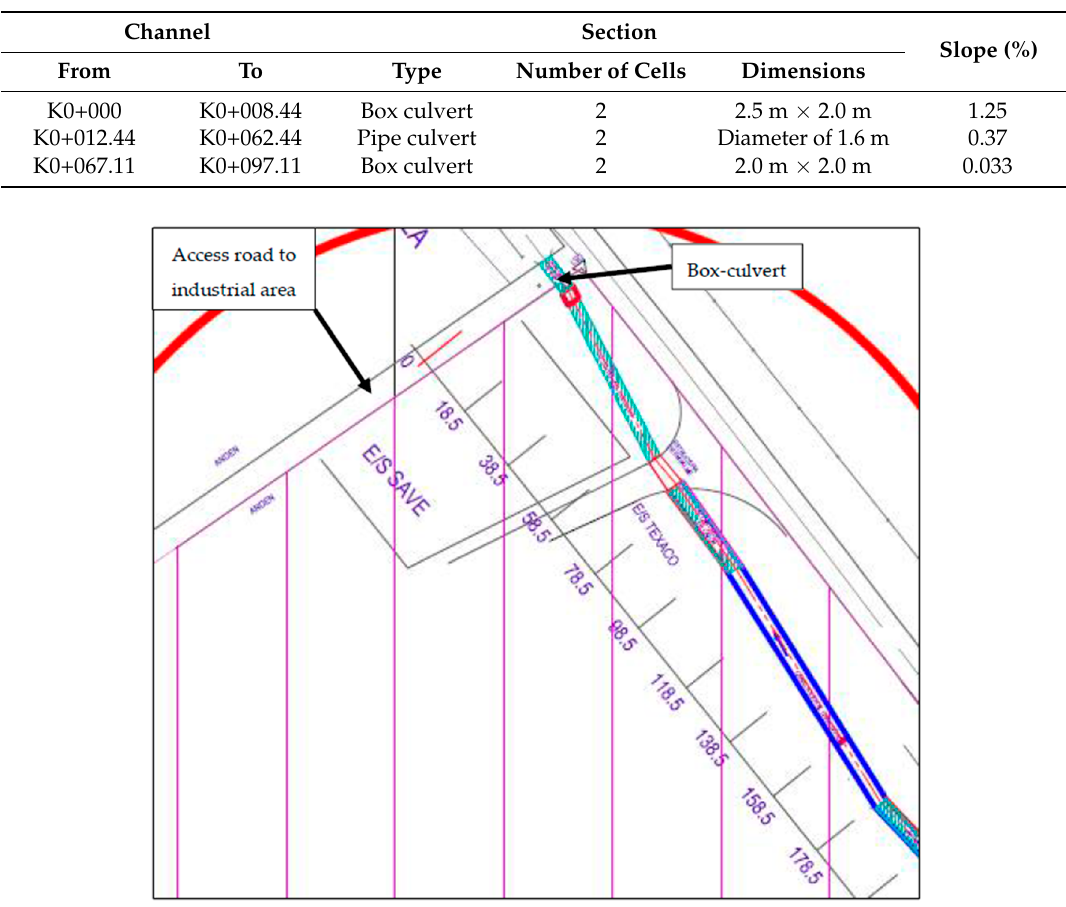
Figure 7. Plant view of the critical point of flooding.